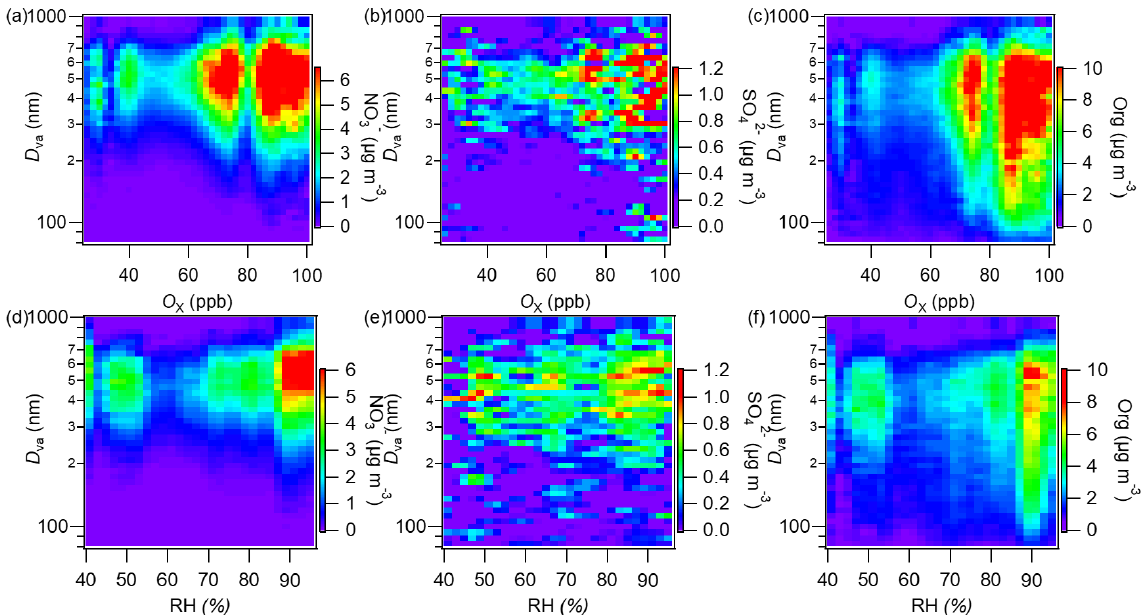
Figure 7. Image plots of the size distributions of rBCc-particle nitrate, sulfate and organics as functions of (a–c) O x and (d–f) RH, respec- tively (the color represents the